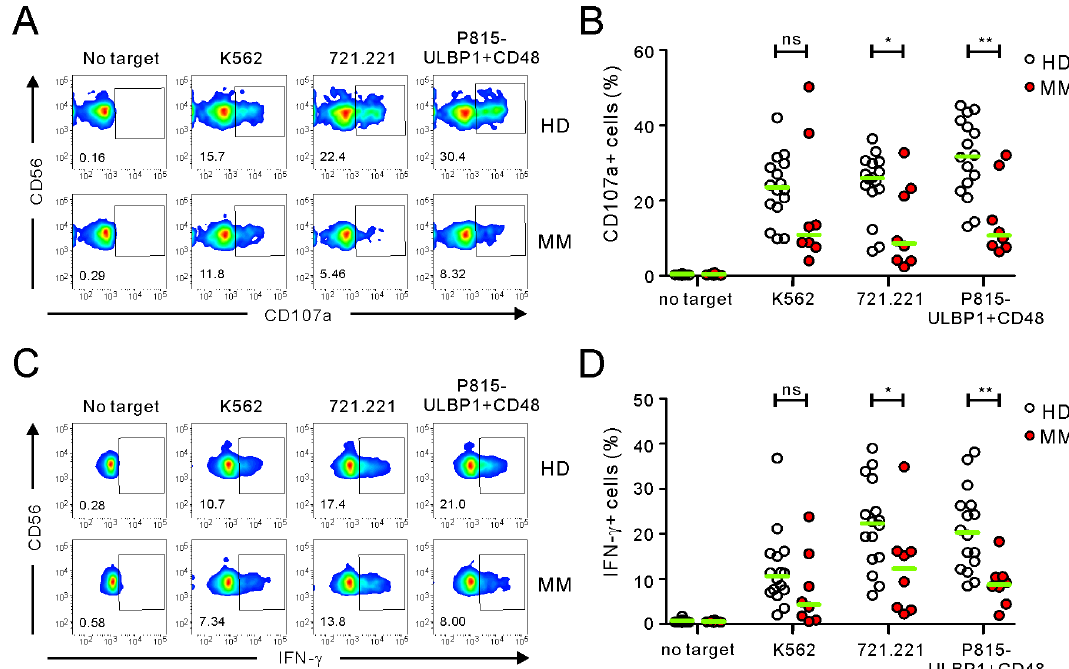
Figure 1. Comparison of natural killer (NK) cell functions between healthy donors (HDs) and patients with multiple myeloma (MM) using the PBMC-based NK cell activity (NKA) assay. Isolated peripheral blood mononuclear cells (PBMCs) from the healthy donor (HD) group ( n = 16), and multiple myeloma (MM) patient group ( n = 8) were co-cultured with K562, 721.221, or P815-ULBP1 + CD48 target cells. ( A , B ) Cytotoxic degranulation of NK cells, as measured by cell surface expression of CD107a using flow cytometry. ( C , D ) IFN- γ production by NK cells, as measured by intracellular expression of IFN- γ using flow cytometry. Representative flow cytometry profiles ( A , C ) and summary graphs ( B , D ) showing the percentages of CD107a + and IFN- γ + NK cells. Horizontal bars (green) indicate the medians. Statistical di ff erences between the groups were evaluated with the nonparametric Mann–Whitney U-test. * p < 0.05 and ** p < 0.01.